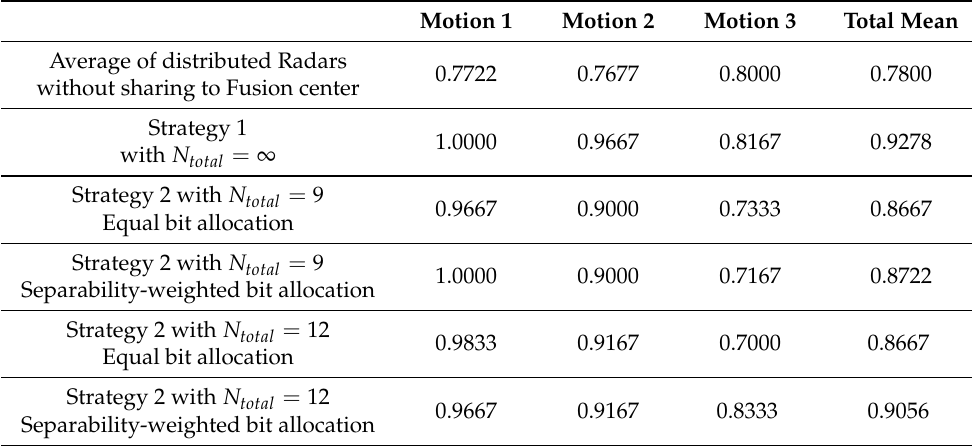
Figure 9. Experimental settings for the distributed radars which were placed close together. Table 2. Classification rates for the experiment in Figure